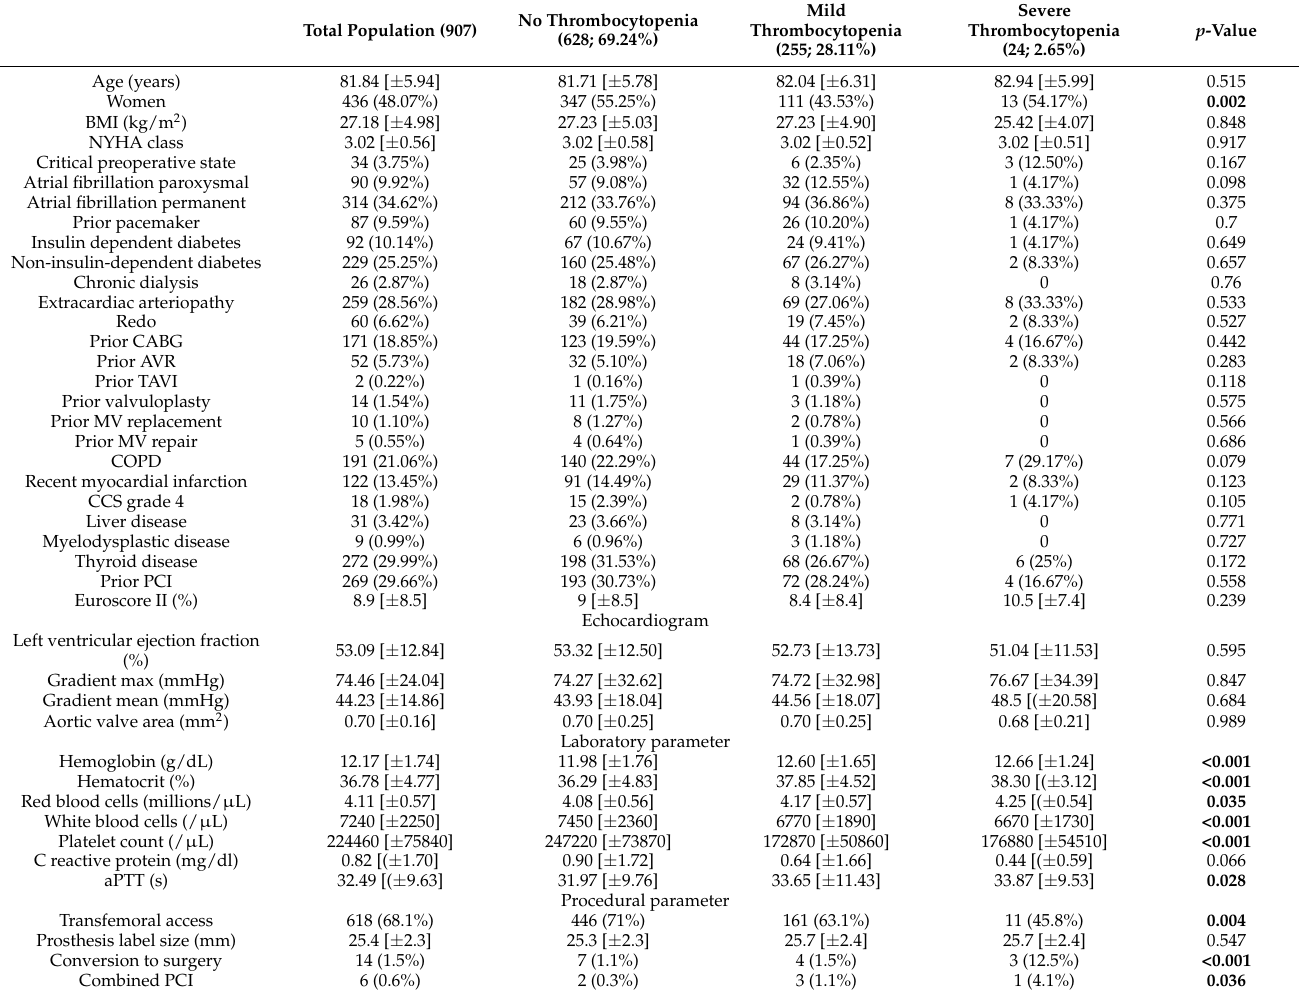
Table 1. Baseline characteristics of study population. Groups are defined according to the onset of postoperative thrombocytopenia. Values are expressed as mean [ ± standard deviation] or n (%). aPTT: activated partial thromboplastin time; AVR: aortic valve replacement; BMI: body mass index; CABG: coronary artery bypass grafting; COPD: chronic obstructive pulmonary disease; MV: mitral valve; PCI: percutaneous coronary